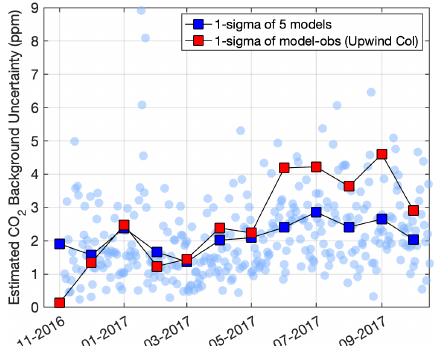
Figure 8. Comparison of two methods for estimating uncertainty on CO 2 background at HAL. The blue squares indicate monthly means of the standard deviation of five different backgrounds (light blue circles are daily). Red points indicate the monthly means of the standard deviation of the difference between modeled and observed mole fractions using the upwind column background during low- footprint periods. The other sites show identical patterns and very similar